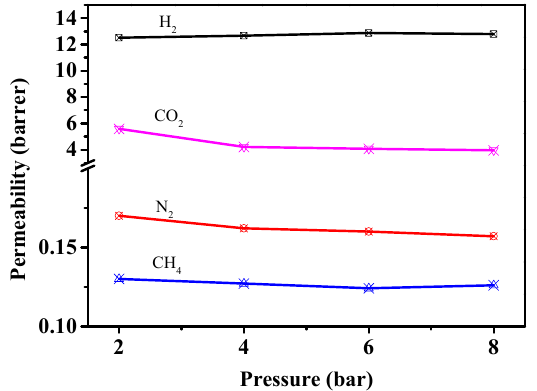
Figure 9. H 2 , N 2 , CH 4 and CO 2 pure gas permeability of PI-50 wt% ATP composite membranes at different gas pressures.